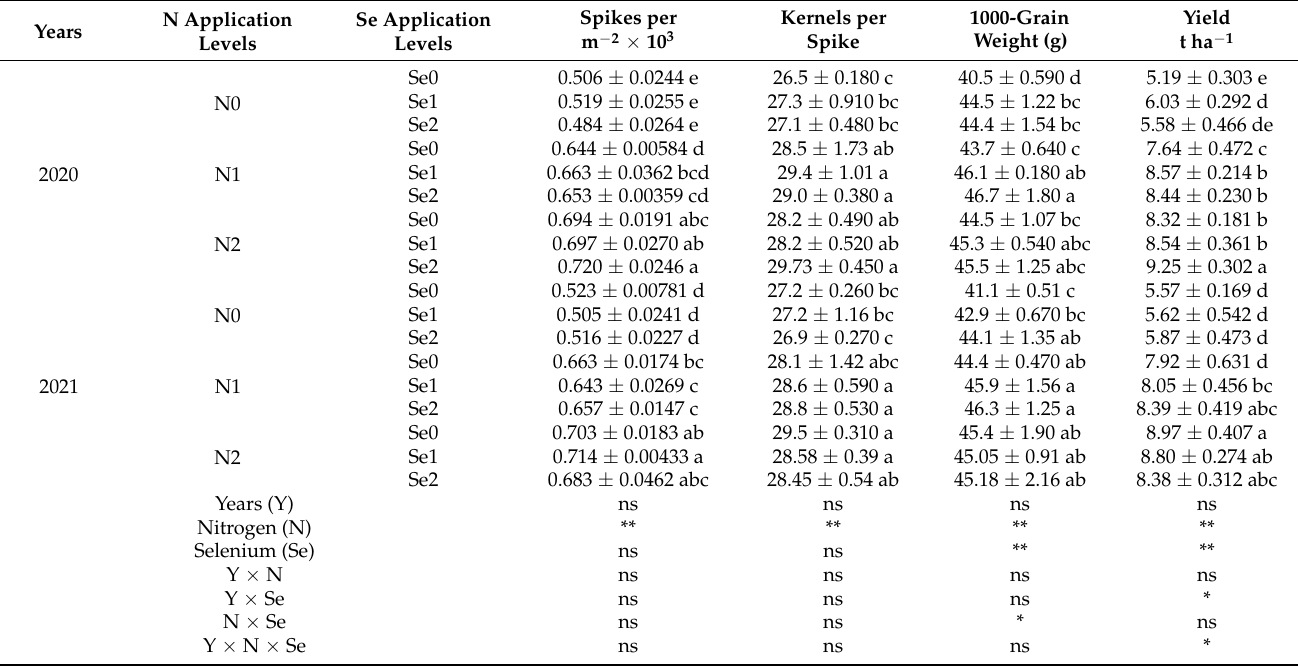
Table 1. Effects of selenium and N fertilizers on wheat yield and yield